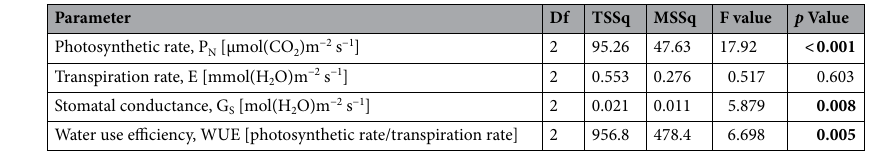
Table 3. Summary of one-way ANOVA results showing the effect of ‘seasonal gradient’ factor on leaf gas exchange parameters of R. anthopogon . Df degree of freedom, TSSq total sum of squares and MSSq mean sum of squares. Significant values are in